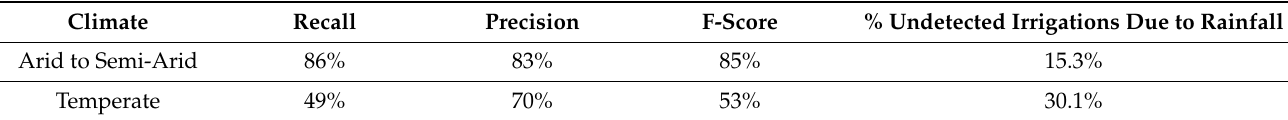
Table 4. Recall, precision and F-score per climatic